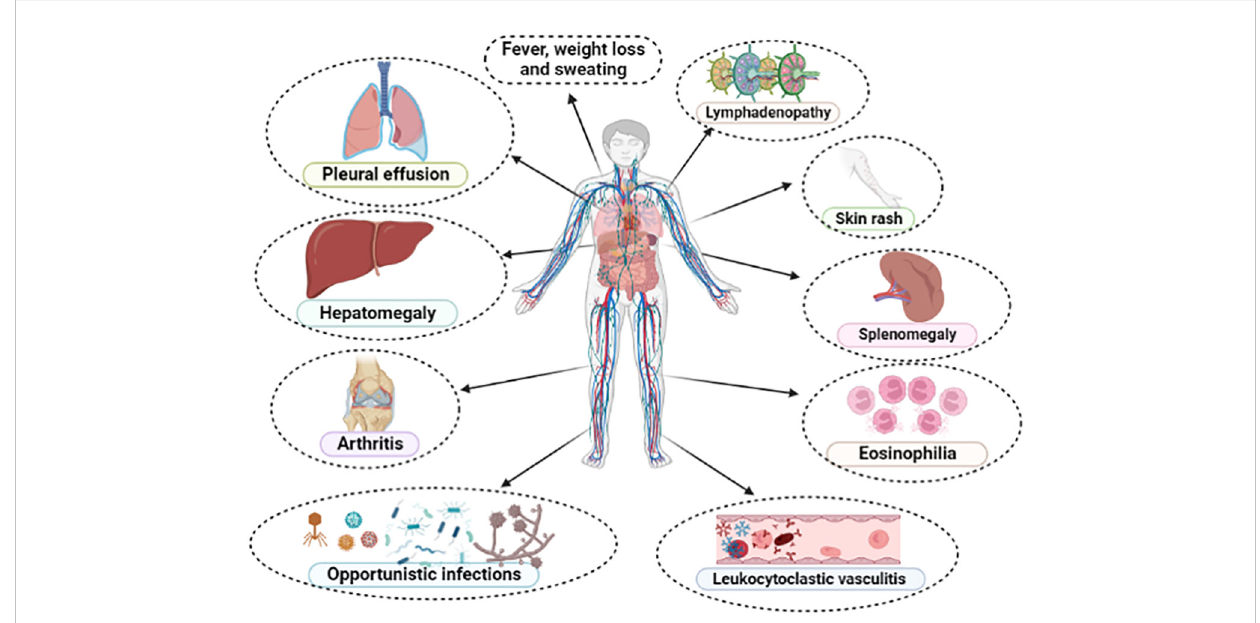
FIGURE 4 Main clinical and laboratory fi ndings presented in typical cases of angioimmunoblastic T-cell lymphoma (AITL). All these manifestations compose the so-called “ angioimmunoblastic lymphoma syndrome ” or “ immunodysplastic syndrome ” , establishing differential diagnosis with drug-reactions, collagenoses and exanthematic viral